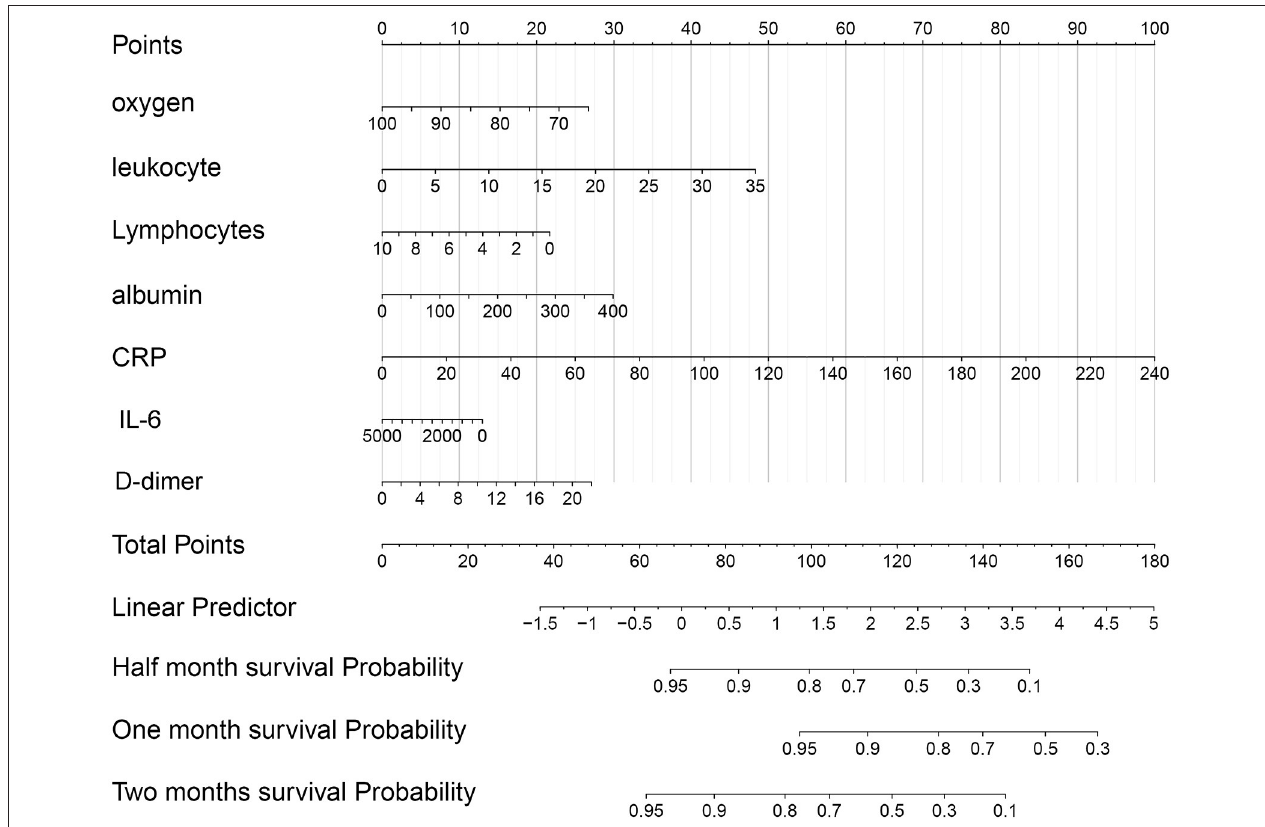
FIGURE 8 | The nomogram of the seven indicators was used to predict the overall survival (OS) of COVID-19 patients.